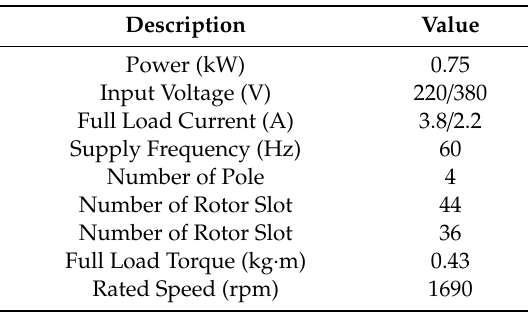
Table 1. Motor Table 1. Motor specifications.